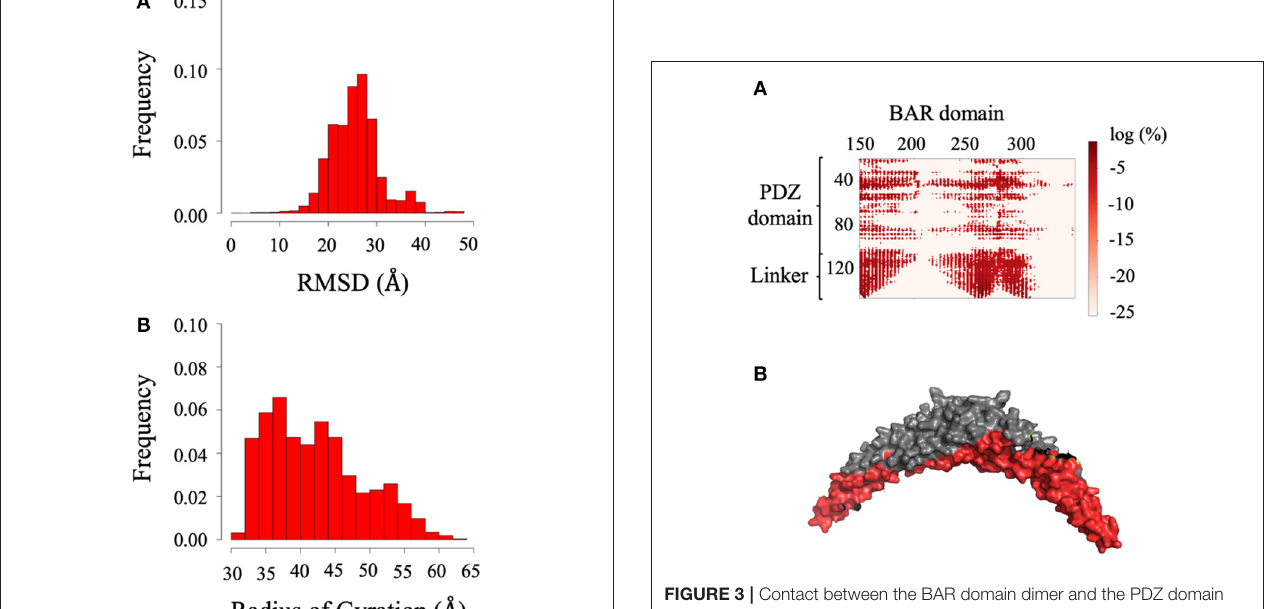
FIGURE 3 | Contact between the BAR domain dimer and the PDZ domain and linker. (A) Contact map of BAR domain with PDZ domain and linker region. PDZ domain and linker region interact with approximate residues 150–200 and 250–300 of the BAR domain. (B) Dimeric BAR domain with residues 150–200 and 250–300 colored red. The color bar describes the probability of the contact as the log of the percentage of frames that the contact